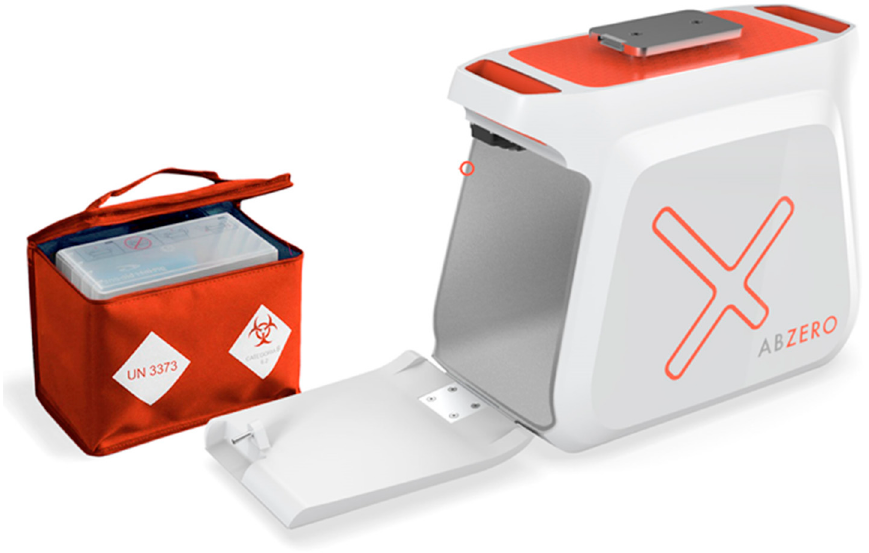
Figure 1. Smart Capsule 3D view with UN3373 container for blood sample delivery .